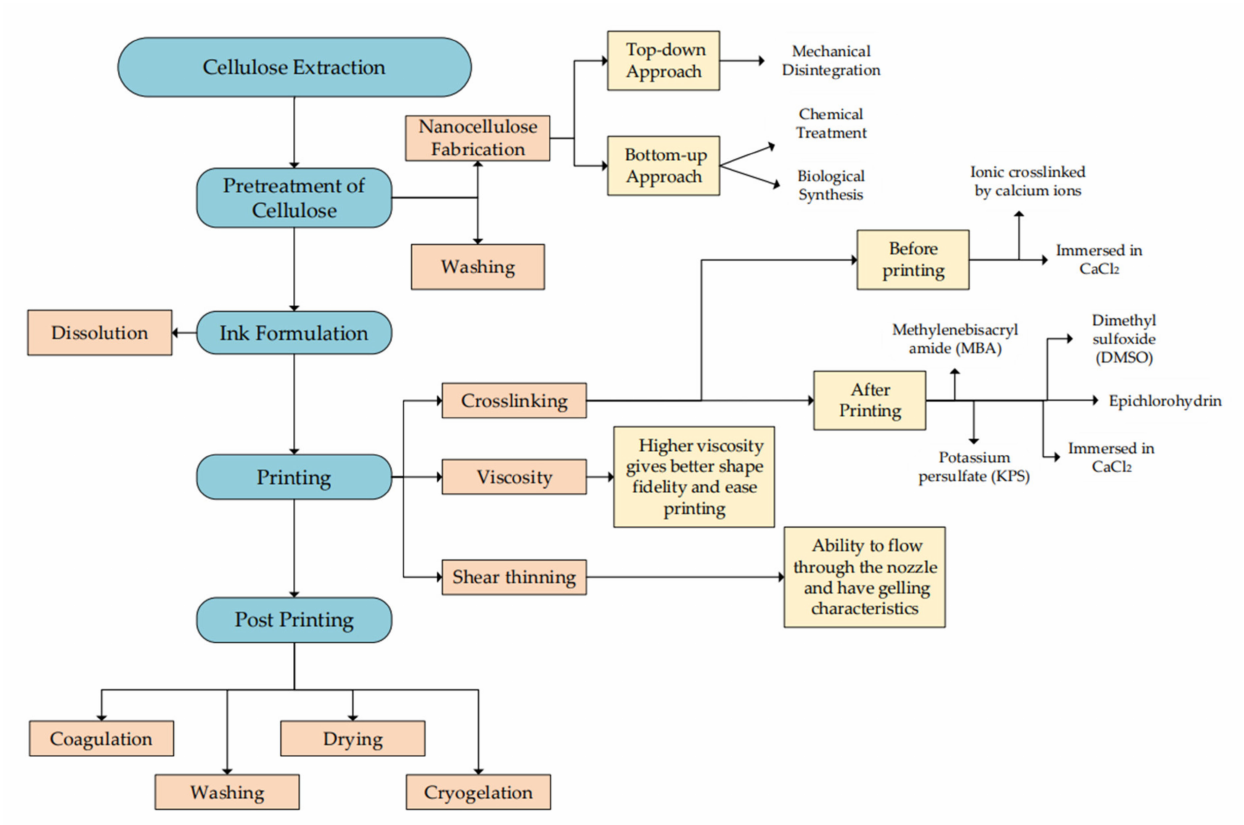
Figure 6. Preparation techniques in producing cellulose and nanocellulose by top-down and bottom- up approaches involve mechanical disintegration, chemical treatment, and biological